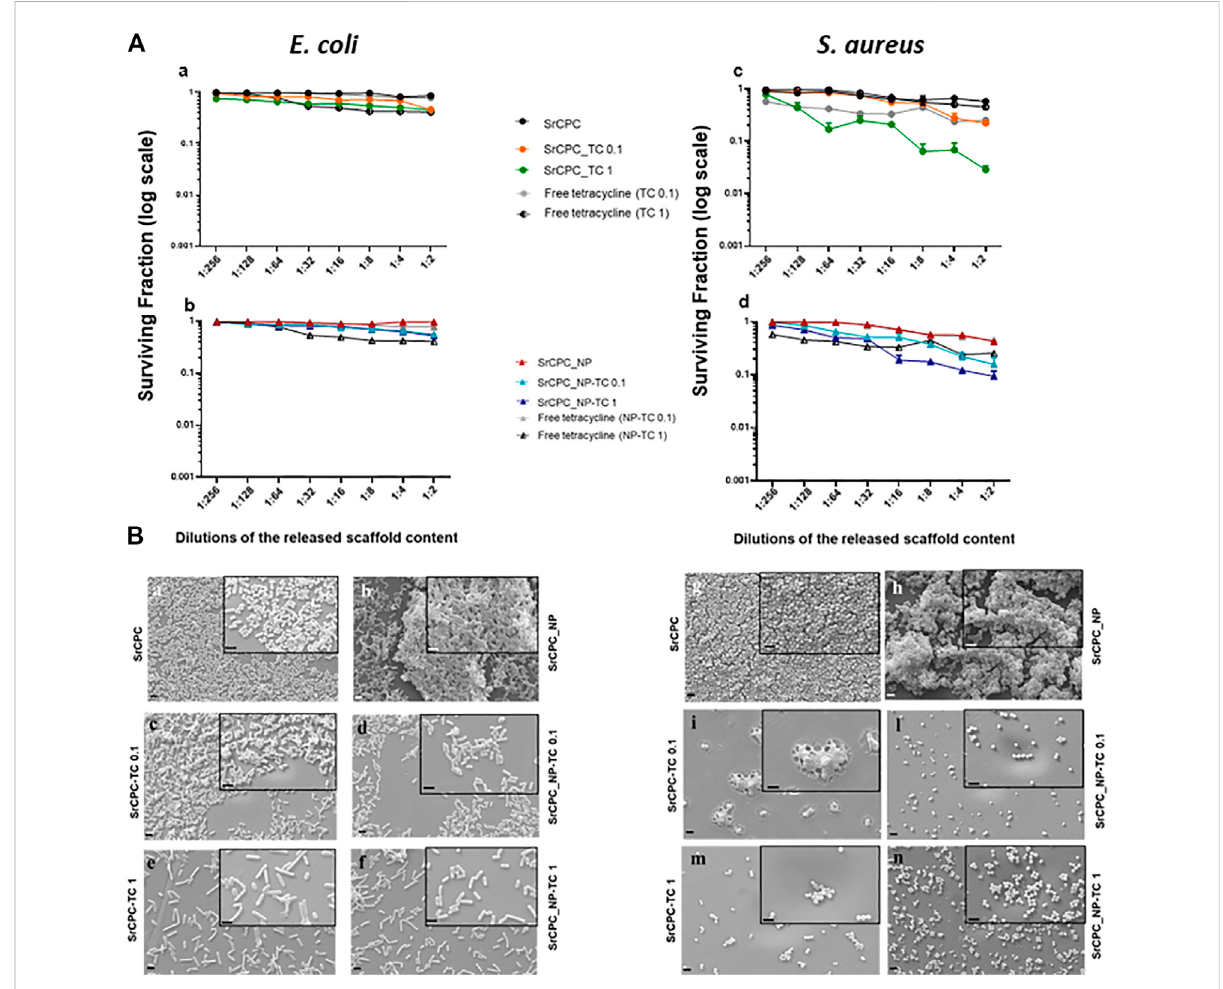
FIGURE 9 Effect of scaffold released contents on bacterial preformed bio fi lms (Post-bio fi lm conditions). (A) Viability of bacterial bio fi lms. Each scaffold was incubated with LB medium, for 24 h at 37 ° C. The overnight solutions containing ions and tetracycline were added at the overnight preformed bacterial bio fi lms of E. coli (a,b) and S. aureus (c,d) at the dilutions indicated for 24 h at 37 ° C. Tetracycline-HCl powder (in fi gure indicated as free tetracycline 0.1; 1) was dissolved in LB according to the same concentrations released from SrCPC_TC and SrCPC_NP-TC scaffolds after 24 h at 37 ° C. The data (log scale) were represented as the surviving fraction. p < 0.05 (data not shown). (B) SEM images. Bacteria were seeded onto coverslips and incubated for 24 h at 37 ° C for bio fi lm formation. After the removal of planktonic bacteria form the coverslips, the previously obtained overnight solutions form the doped and undoped scaffolds were serially diluted and incubated for 24 h at 37 ° C onto each bio fi lm. At the end of incubation after removal of the medium, the cells were treated as indicated in materials and methods and observed by SEM. Images of the samples were performed at magni fi cation 6KX (2 μ m bar) and 15KX (insets, 1 μ m bar), respectively. SrCPC (a,g) ; SrCPC_NP (b,h) ; SrCPC_TC 0.1 mg/ml (c,i) and 1 mg/ml (e,m) ; SrCPC_NP-TC 0.1 mg/ml (d,l) and 1 mg/ml (f,n)